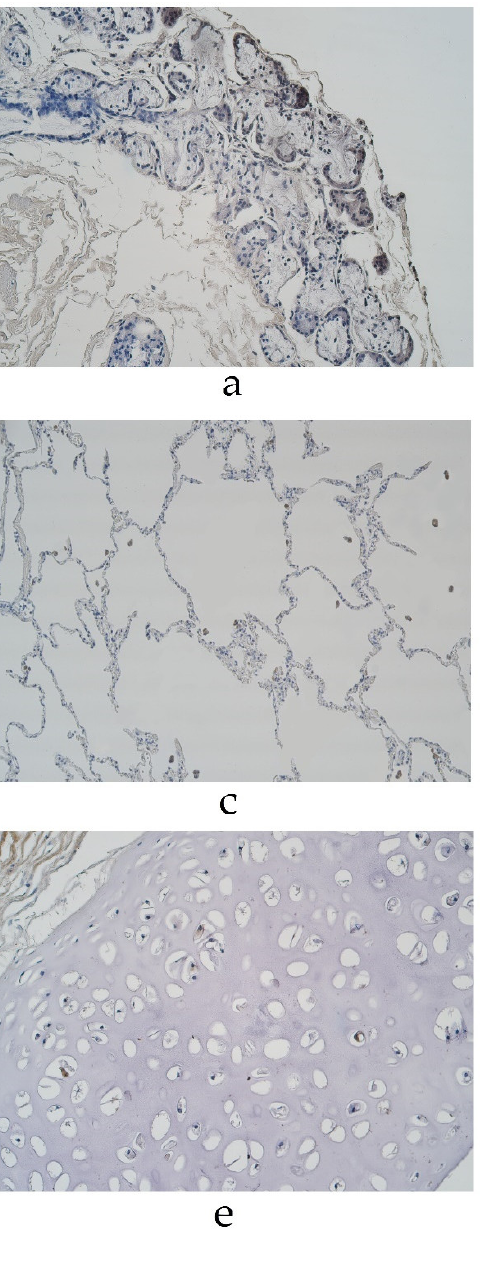
Figure 2. Immunohistochemical micrographs of the lungs. ( a ) MUC-2 positive cells in glands of 94-year-old male in the pseudostratified ciliated epithelium group. MUC-2 IMH, X200. ( b ) A few MUC-2 positive alveolar macrophages in ac56- year-old male in the pseudostratified ciliated epithelium group. MUC-2 IMH, X200; ( c ) A few to a moderate number of MUC-2 positive alveolar macrophages observed in a 23-year-old male in the stratified squamous epithelium group. MUC- 2 IMH, X200; ( d ) Occasional MUC-6 positive cells in cartilage of 55-year-old female in the pseudostratified ciliated epithe- lium group. MUC-6 IMH, X200; ( e ) Occasional number of MUC-6 positive cells in cartilage of 67-year-old male in the stratified squamous epithelium group. MUC-6 IMH, X200; ( f ) A few MUC-6 positive alveolar macrophages in 25-year-old male in the stratified squamous epithelium group. MUC-6 IMH,